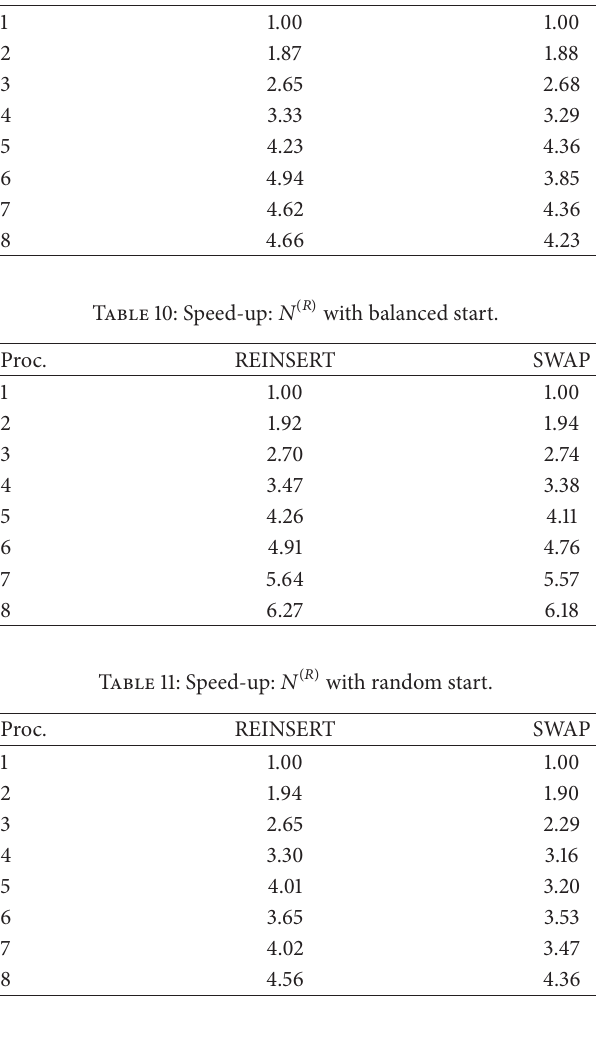
Table 9: Speed-up: 𝑁 ( CF ) with random start. Proc.